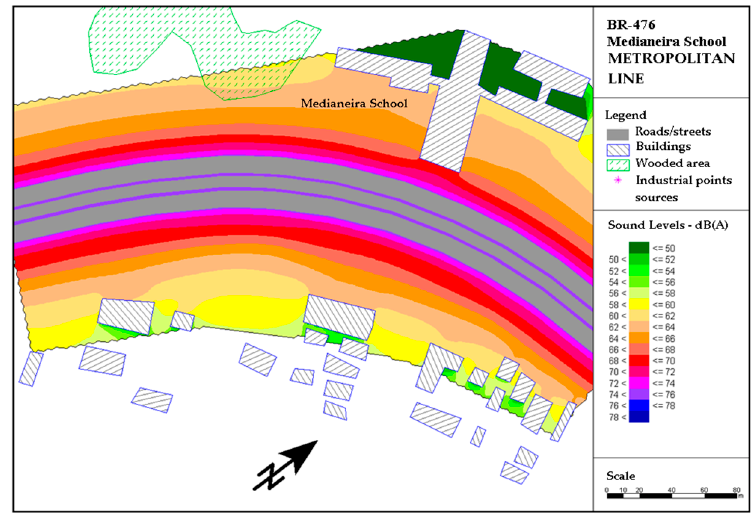
Figure 3. Simulation of the operationalization phase of the highway reconstruction project in the surroundings of Medianeira School.